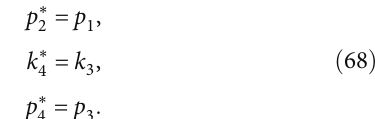
= η 0 = η 0 = 0 Þ 3 4 5